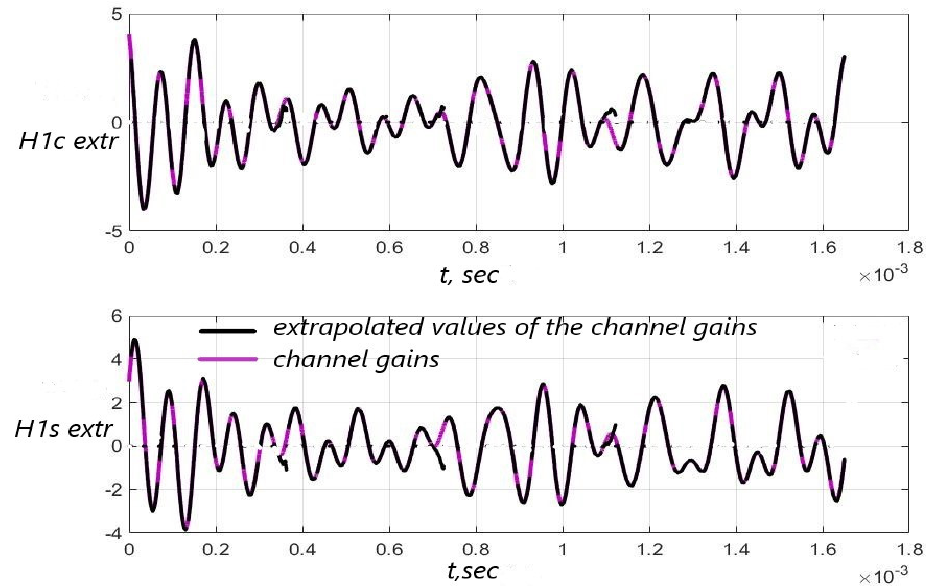
( i ) , H ( i ) versus time for Figure 16. Extrapolated values of the channel gains Figure 16. Extrapolated values of the channel gains H 1 c 1 s ( F + ∆ f ) T = 3.5 × 10 − 3 and p = 1, SNR = 26 dB. D Figure 16. Extrapolated values of the channel gains 64-QAM using algorithms, described = and 1 p , SNR = 26 dB.